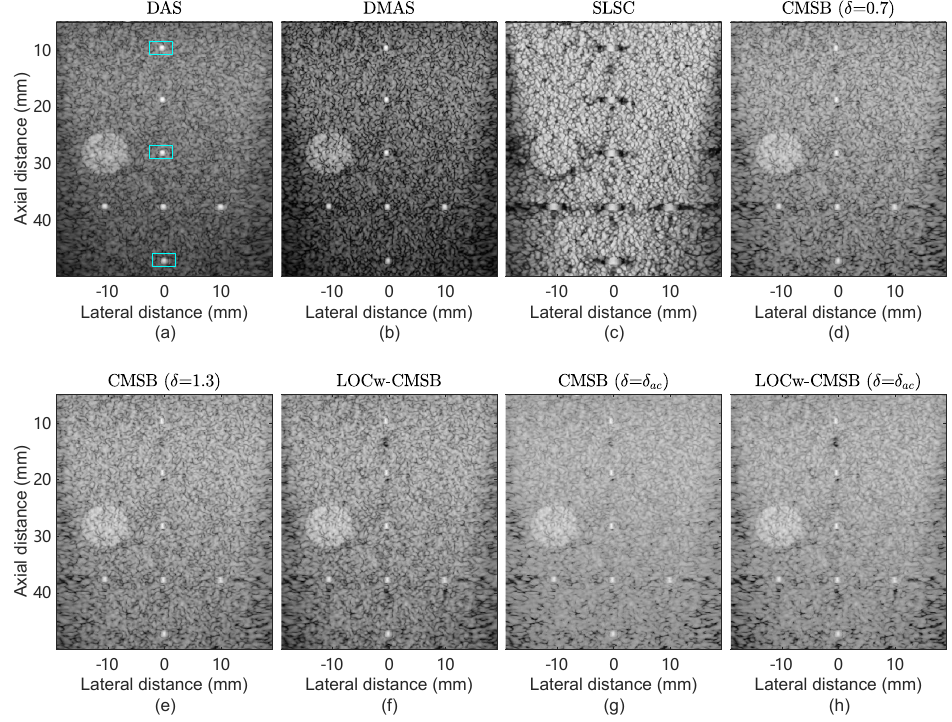
Figure 4. Experimental point images reconstructed by ( a ) DAS, ( b ) DMAS, ( c ) SLSC, ( d ) CMSB ( δ = 0.7), ( e ) CMSB ( δ = 1.3), ( f ) LOCw-CMSB, ( g ) CMSB ( δ = δ ac ), and ( h ) LOCw-CMSB ( δ = δ ac